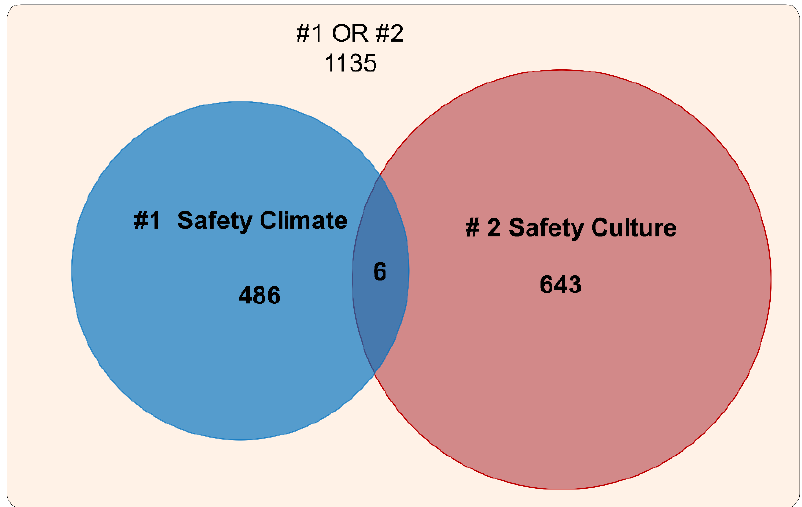
Figure 1. Venn diagram of papers in SSCI and SCIE (August 2019) including “safety climate” or “safety culture” in the title